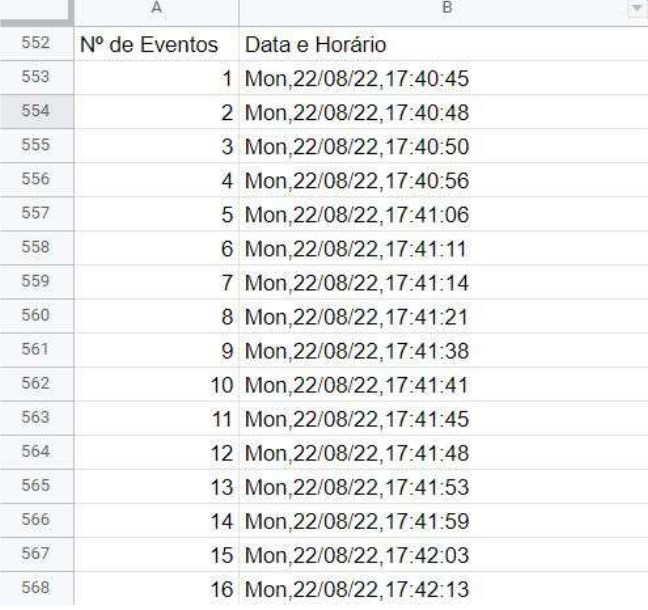
Figure 10. Recording the number of apneic events on the database.